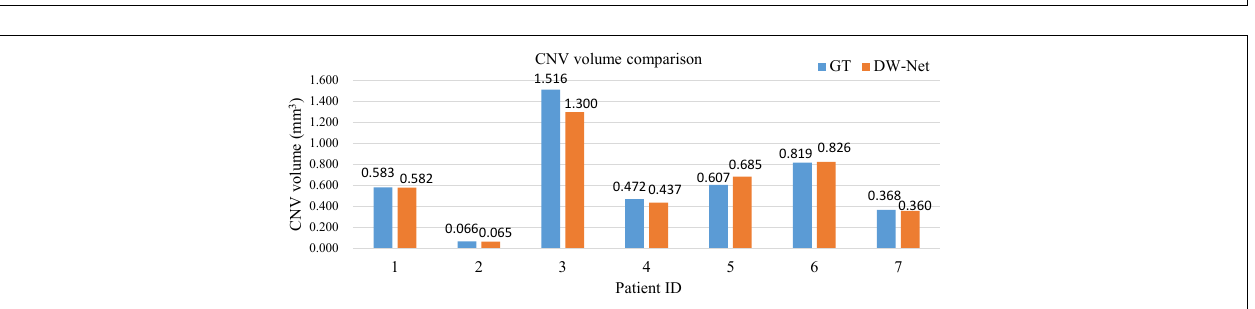
FIGURE 5 | Visualization results of the different methods.